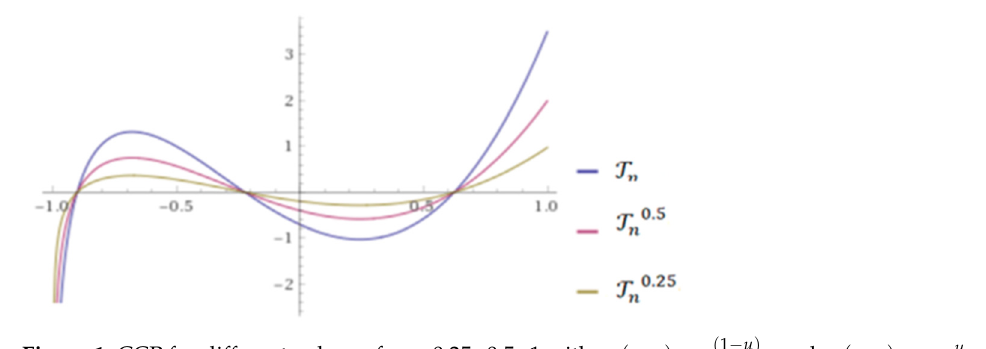
and η 0 ( u , y ) = u Γ ( 1 + u ) ( 1 + u ) and η (cid:2868) ( 𝓊 , 𝓎 ) = (cid:3056) ( (cid:2869)(cid:2878)𝓊 )